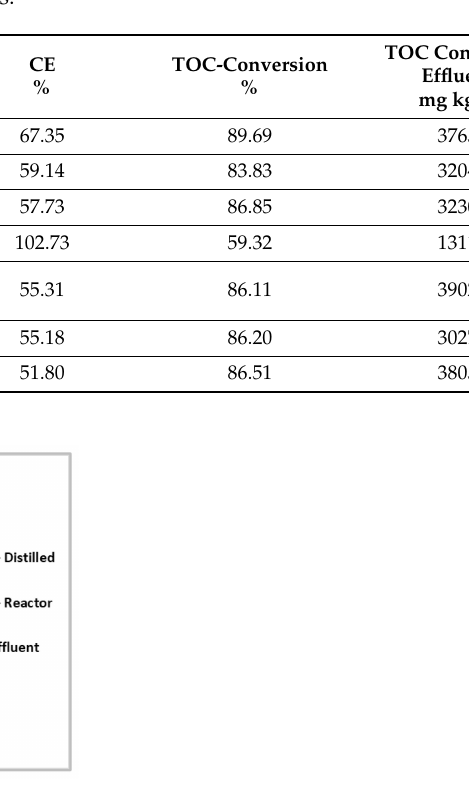
Table 3. Results of gasification experiments.